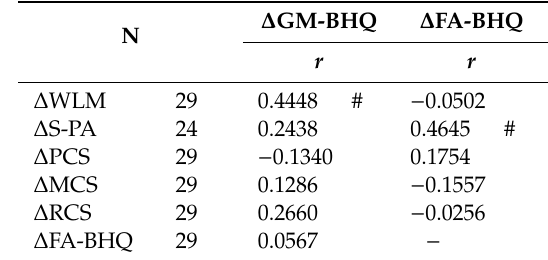
Table 5. Correlations among the primary and secondary outcome measures.